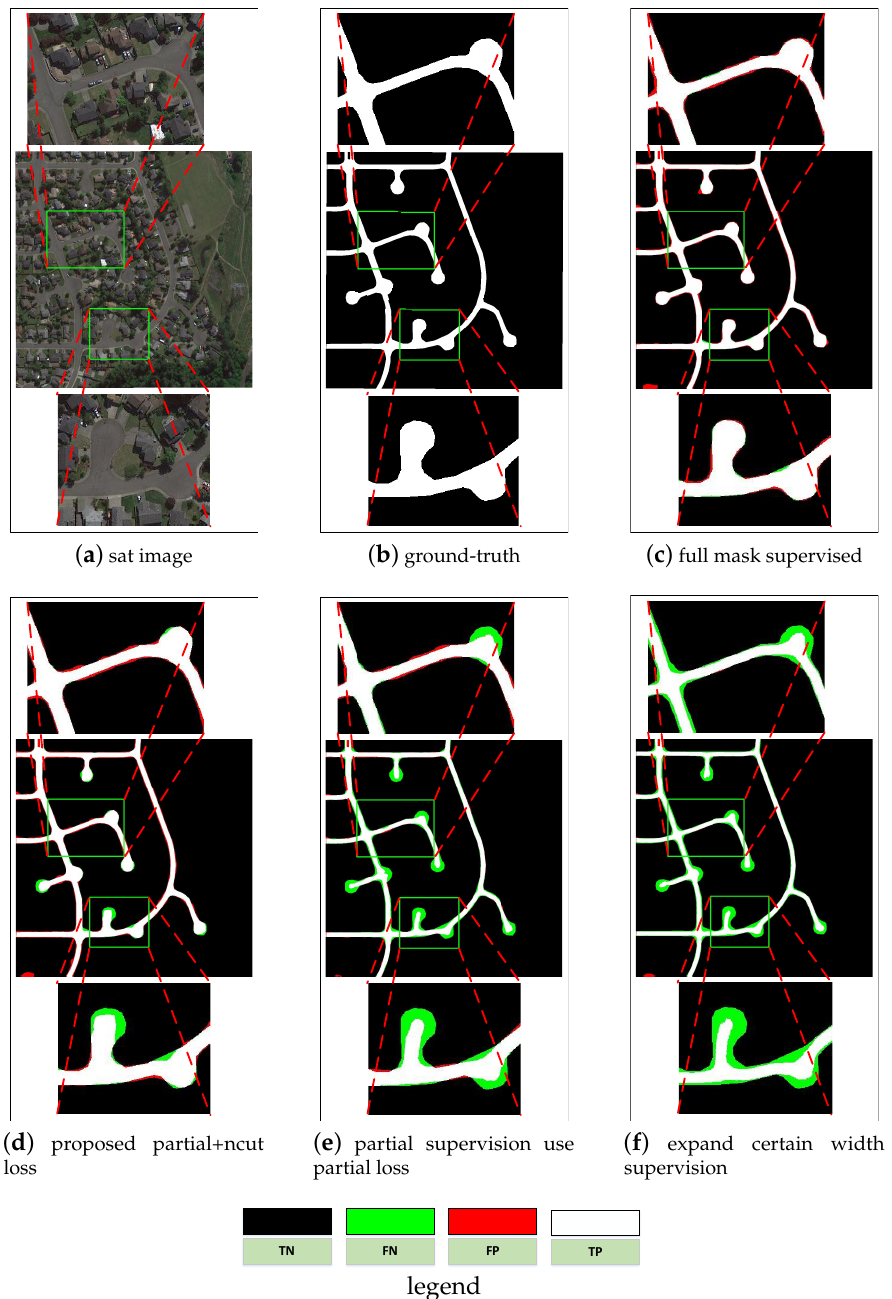
Figure 7. A sample for results with different methods on dataset 2. ( a ) represents the satellite; ( b ) is the pixel-wise ground truth; ( c ) is the extracting road using full supervised MD-ResUNet; ( d ) uses the partial loss combined with normalized cut loss; ( e ) uses the partial loss function; ( f ) is supervised by the expand